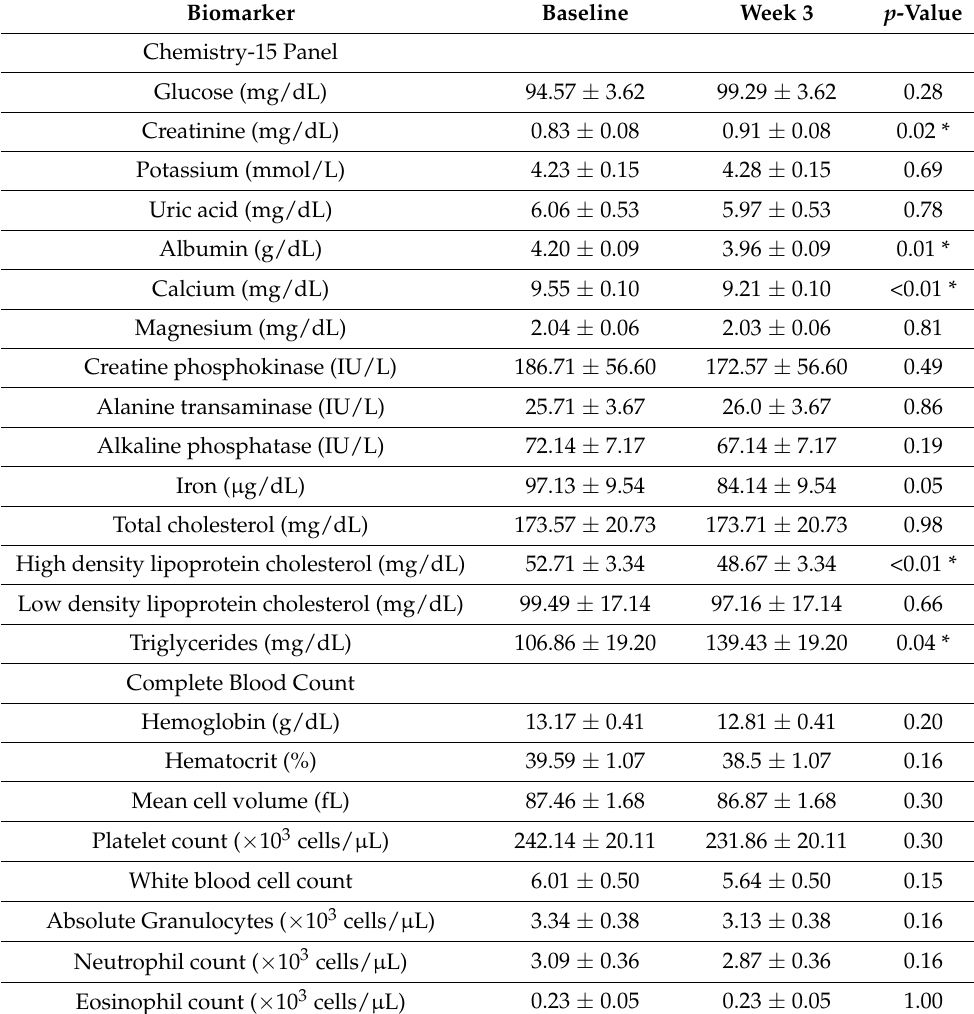
Table 4. Changes in blood biomarkers from baseline to week